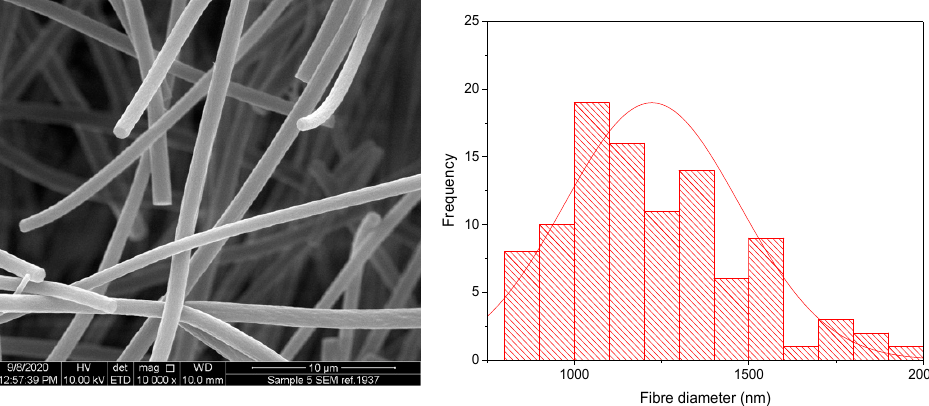
Figure 2. SEM of Electrospun KCT fibres in addition to a fibre diameter distribution histogram.